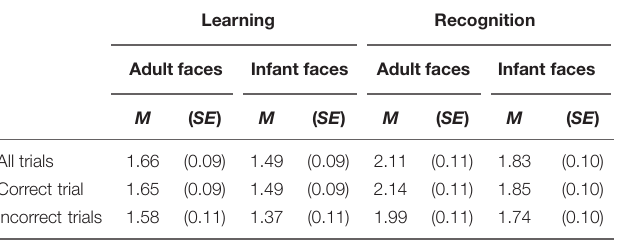
TABLE 3 | The mean and standard error of the number of visit per second for the adult and infant face conditions separately for the learning and recognition phases.